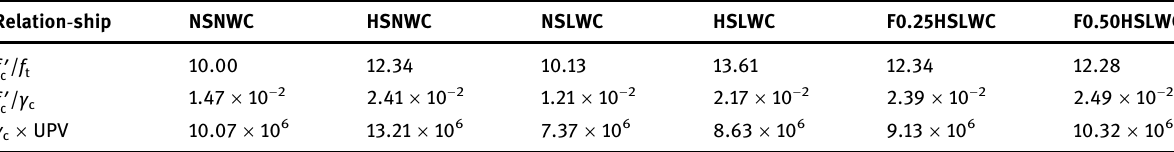
Table 4: The relationships between some of the mechanical and physical properties Relation - ship